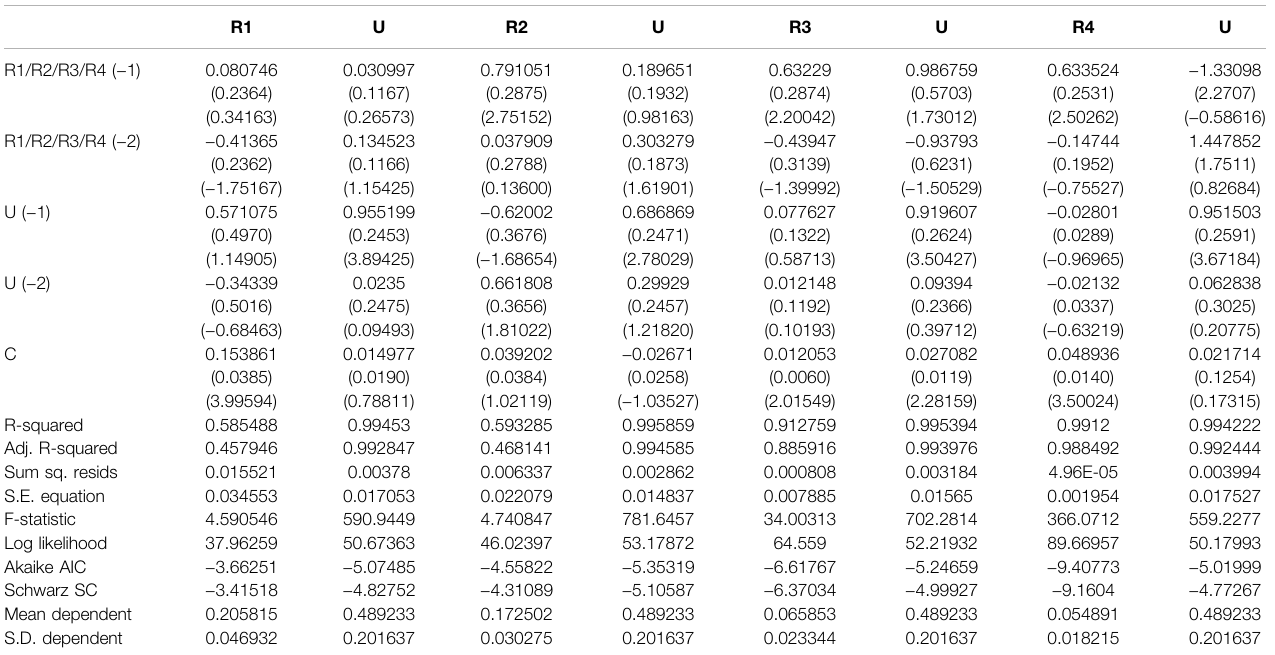
TABLE 5 | VAR model estimation results.